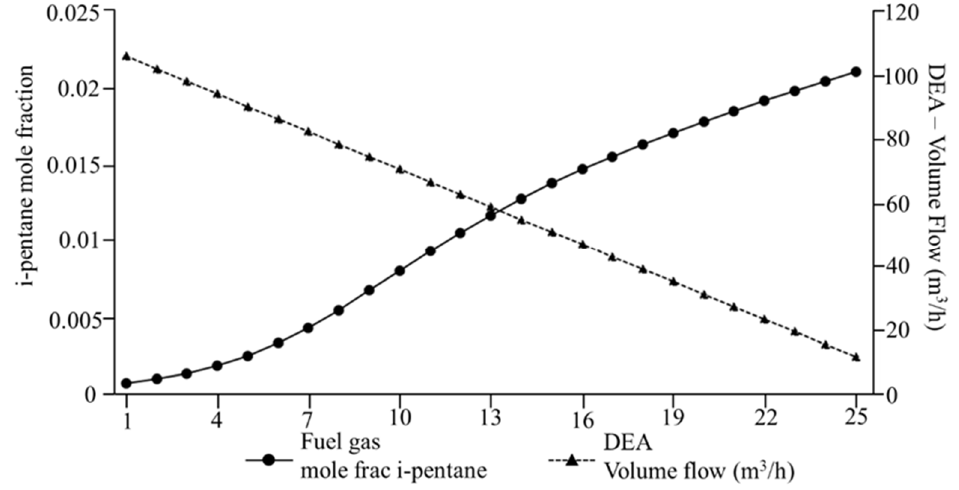
Figure 5. DEA volume flow vs. i-pentane mole fraction.